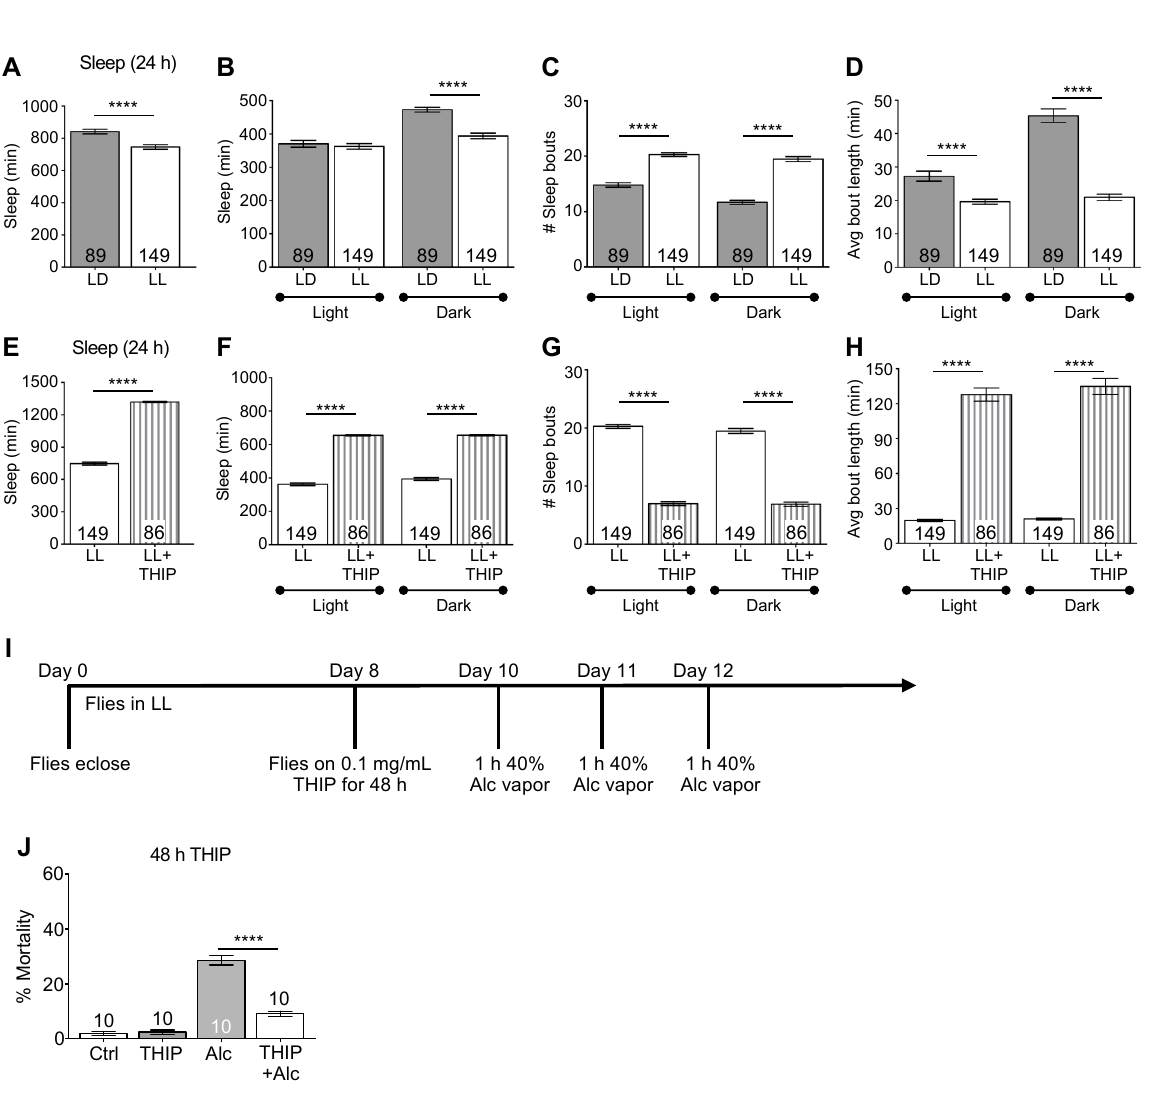
Figure 8. Pharmacologically increasing sleep in flies that are circadianly disrupted reduces mortality following repeated exposures to alcohol. ( A – D ) Comparison of sleep profiles between male 10 d CS flies housed in LD cycles and 10 d flies housed in constant light conditions (LL). Compared to control flies grown in a 12:12 h LD cycle, 10 d CS flies grown in LL exhibited significantly decreased total sleep time per day (( A ) [ t (236) = 4.46, p < 0.0001)]) with decreased total sleep during the subjective night (( B ) ANOVA: F 3,442 = 27.31, p < 0.0001). More fragmented sleep was observed in LL during the day and subjective night with an increased number of sleep bouts (( C ) ANOVA: F 3,442 = 98.99, p < 0.0001) and decreased bout duration compared to flies maintained in LD (( D ) ANOVA: F 3,442 = 78.45, p < 0.0001). LL 10 day flies fed 0.1 mg/mL THIP exhibited significantly more sleep compared to 10 d LL flies on control media (( E ) t (233) = 29.43, p < 0.0001), increased sleep time during both the day and subjective night (( F ) ANOVA: F 3,463 = 437.1, p < 0.0001), decreased number of sleep bouts (( G ) ANOVA: F 3,463 = 358.1, p < 0.0001), and increased bout duration (( H ) ANOVA: F 3,463 = 277.6, p < 0.0001). ( I ) To determine whether increasing sleep was sufficient to ameliorate alcohol-induced mortality under conditions of circadian disruption, CS flies were housed in LL upon eclosion and transferred to media containing 0.1 mg/mL THIP on day 8 for 48 h. On days 10, 11, and 12, flies were subjected to a three-exposure repeated binge-like alcohol paradigm with 1 h alcohol exposure (50% alcohol vapor) occurring at ZT 9, and mortality was assessed. ( J ) Alcohol-induced mortality in THIP-fed LL flies was drastically reduced compared to control LL flies (ANOVA: F 3,36 = 132.6, p < 0.0001). * indicates significant differences between groups as calculated by Bonferroni post hoc analysis; **** p <